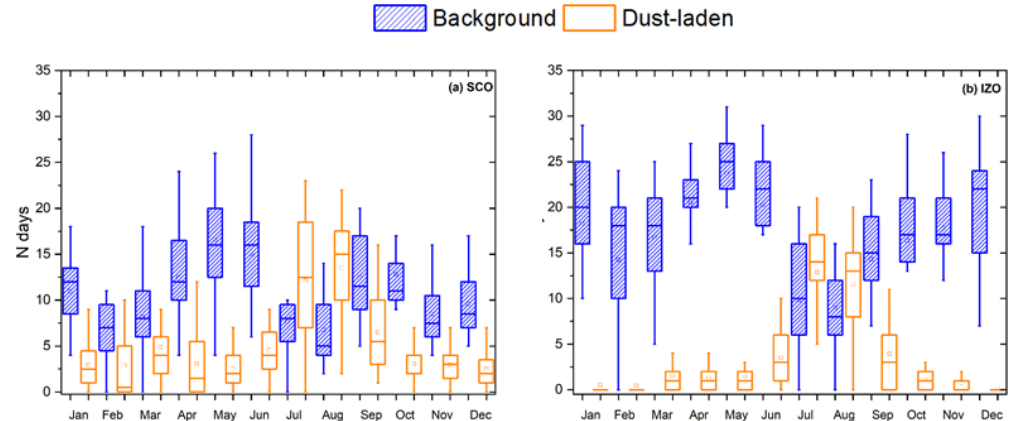
Figure 4. Number of days per month under background and dust-laden conditions at (a) SCO and (b) IZO. The lower and upper boundaries for each box are the 25th and 75th percentiles, the solid line is the median value, and the point represents the mean value. Hyphens at the end of the error bars show the maximum and minimum